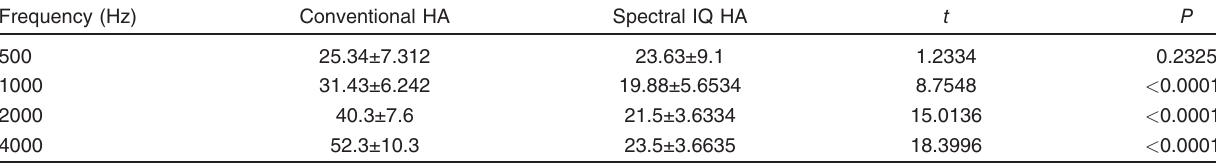
Table 4 Aided pure tone audiometry using conventional hearing aids and spectral IQ Frequency (Hz)